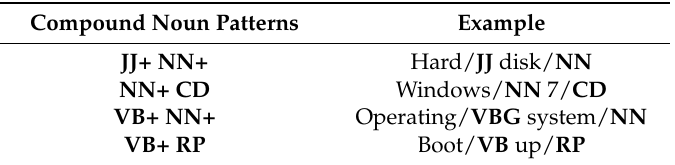
Table 3. Compound noun